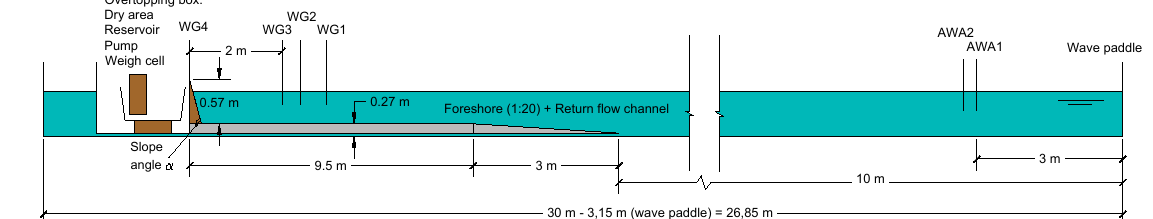
Figure 4. Test setup of the UG experiments (drawing not to